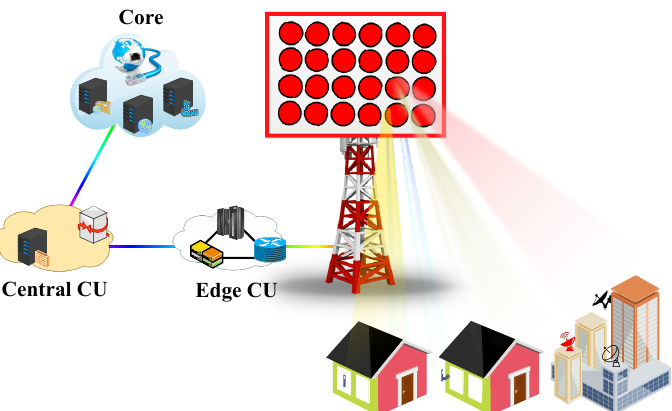
Figure 12. End–to–end FWA networking using MIMO and beamforming (adapted from